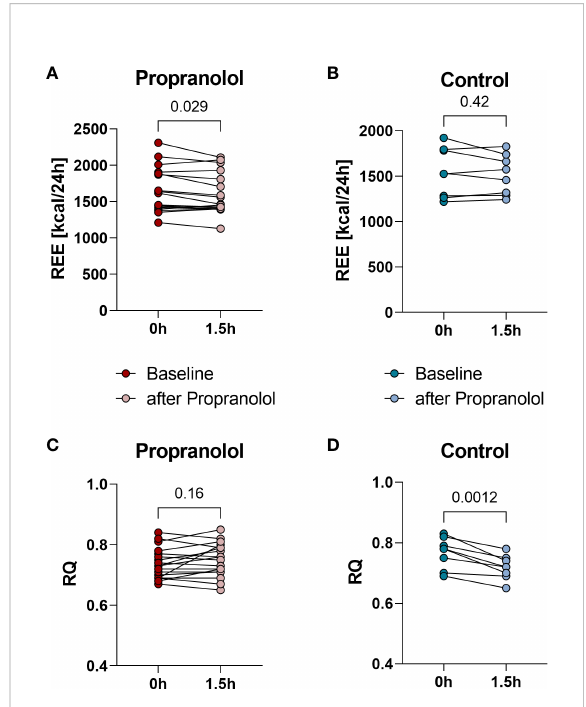
FIGURE 2 Resting energy expenditure (REE) measured at baseline and 90 minutes after a single dose of 80 mg propranolol or after a 90- minute resting period, respectively. REE decreased signi fi cantly (p= 0.029) from baselinie 1639 ± 307 kcal/24h to 1594 ± 283 kcal/24h 90 minutes after administration of propranolol (A) . REE at baseline (1540 ± 272 kcal/24h) and after 90- minutes resting period (1513 ± 220 kcal/24h) showed no signi fi cant change (p=0.42) in control intervention (B) . Respiratory quotient (RQ) at baseline (0.74 ± 0.05) and 90 minutes after Propranolol (0.75 ± 0.055) (p= 0.16) (C) . RQ signi fi cantly decreased (p=0.0012) from 0.77 ± 0.051 (baseline) to 0.72 ± 0.04 (90 minutes after resting period) during the control intervention (D) .